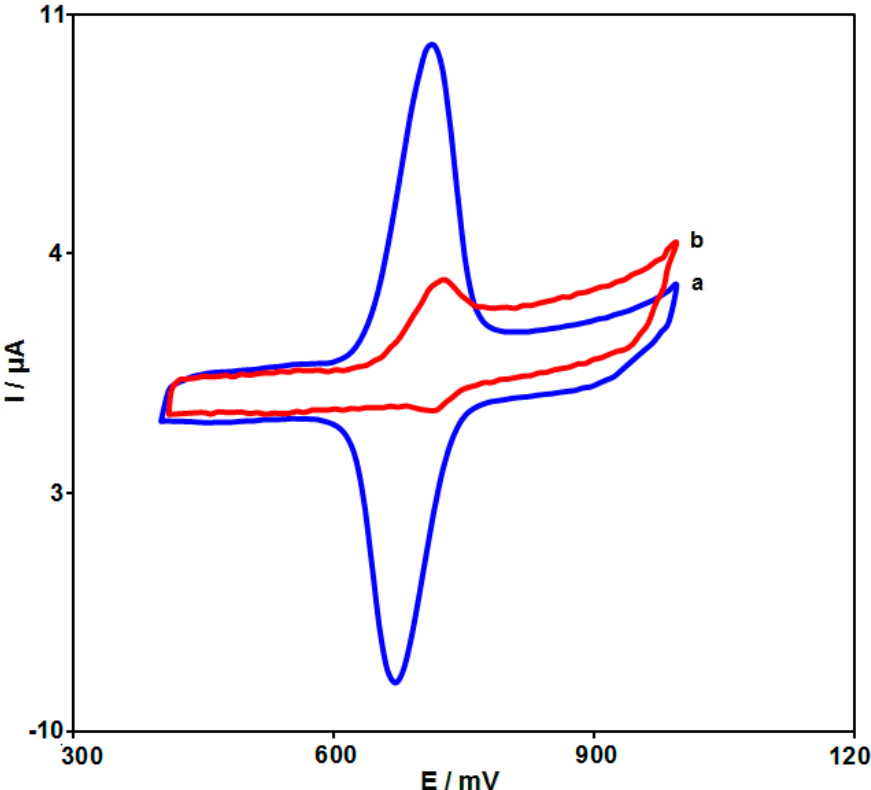
Figure 7. CVs captured for electrochemical reaction of sunset yellow (100.0 µM) in PBS (0.1 M; pH = 7.0) on (a) NiCo 2 O 4 /SPGE and (b) unmodified SPGE with the scan rate of 50